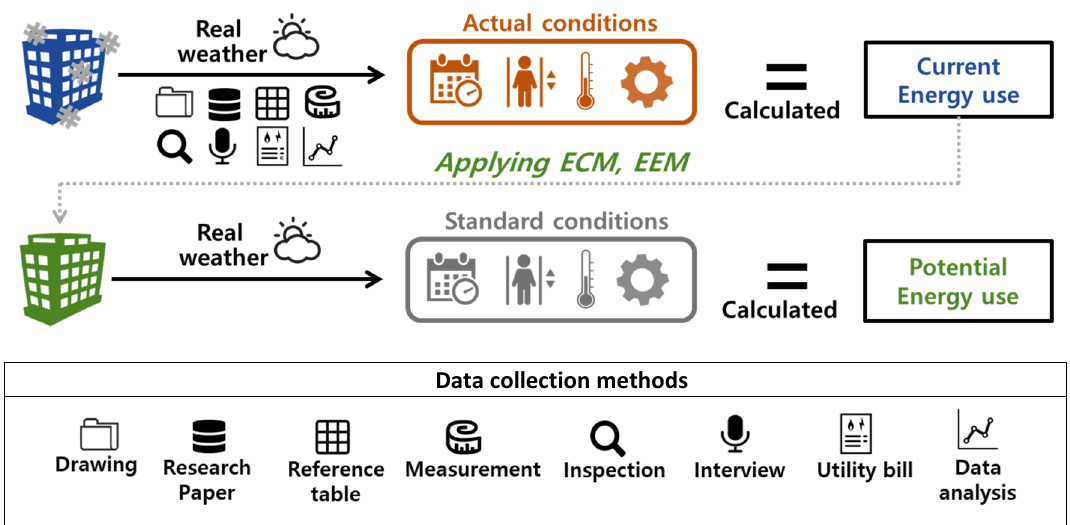
Figure 1. Assessment process of three types of methods by data acquisition level.